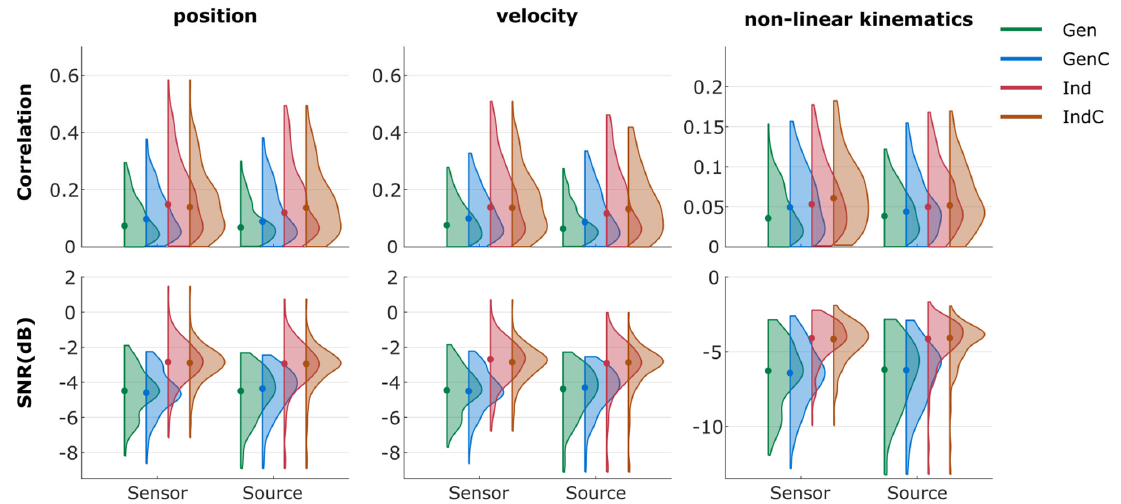
Figure 5. Violin plots of performance metrics. The plots are simplified by merging the measurement blocks and combined into position, velocity, and non-linear kinematics. A dot represents the median value of the corresponding distribution. Color represents the update strategy. Note the different scaling in the non-linear kinematics.